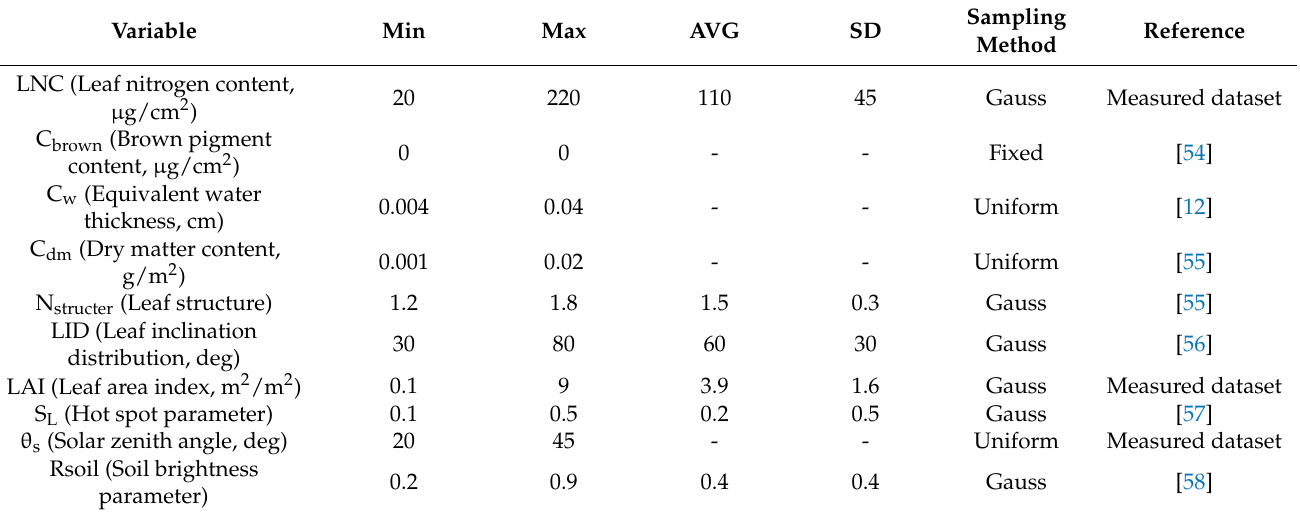
Table 2. Ranges and sampling methods of the input parameters for the N-PROSAIL model.